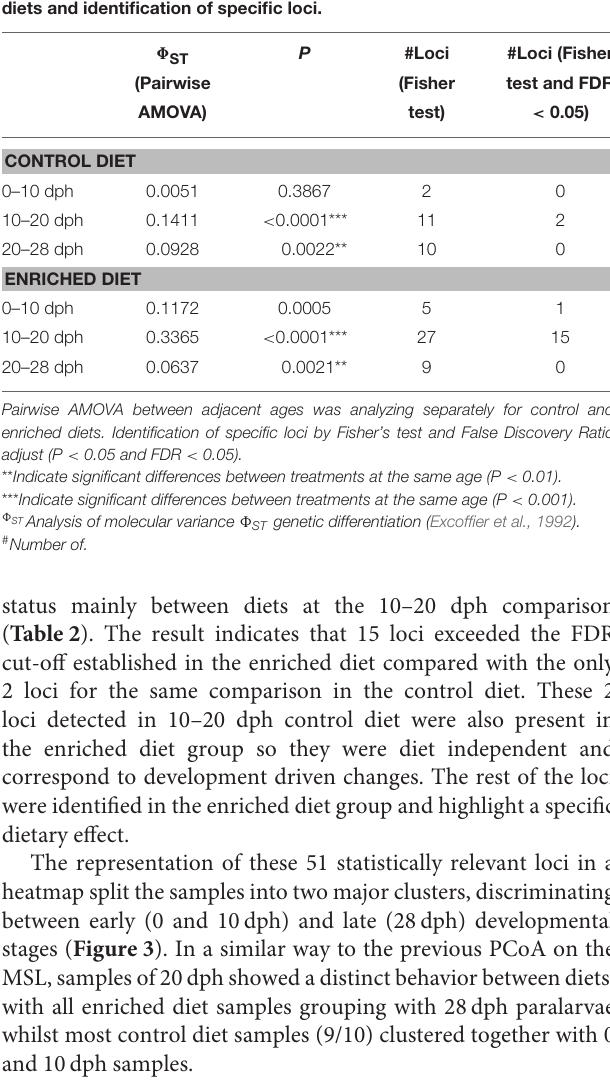
TABLE 2 | Comparisons of methylation-sensitive loci distribution for both diets and identification of specific loci. 8 ST P